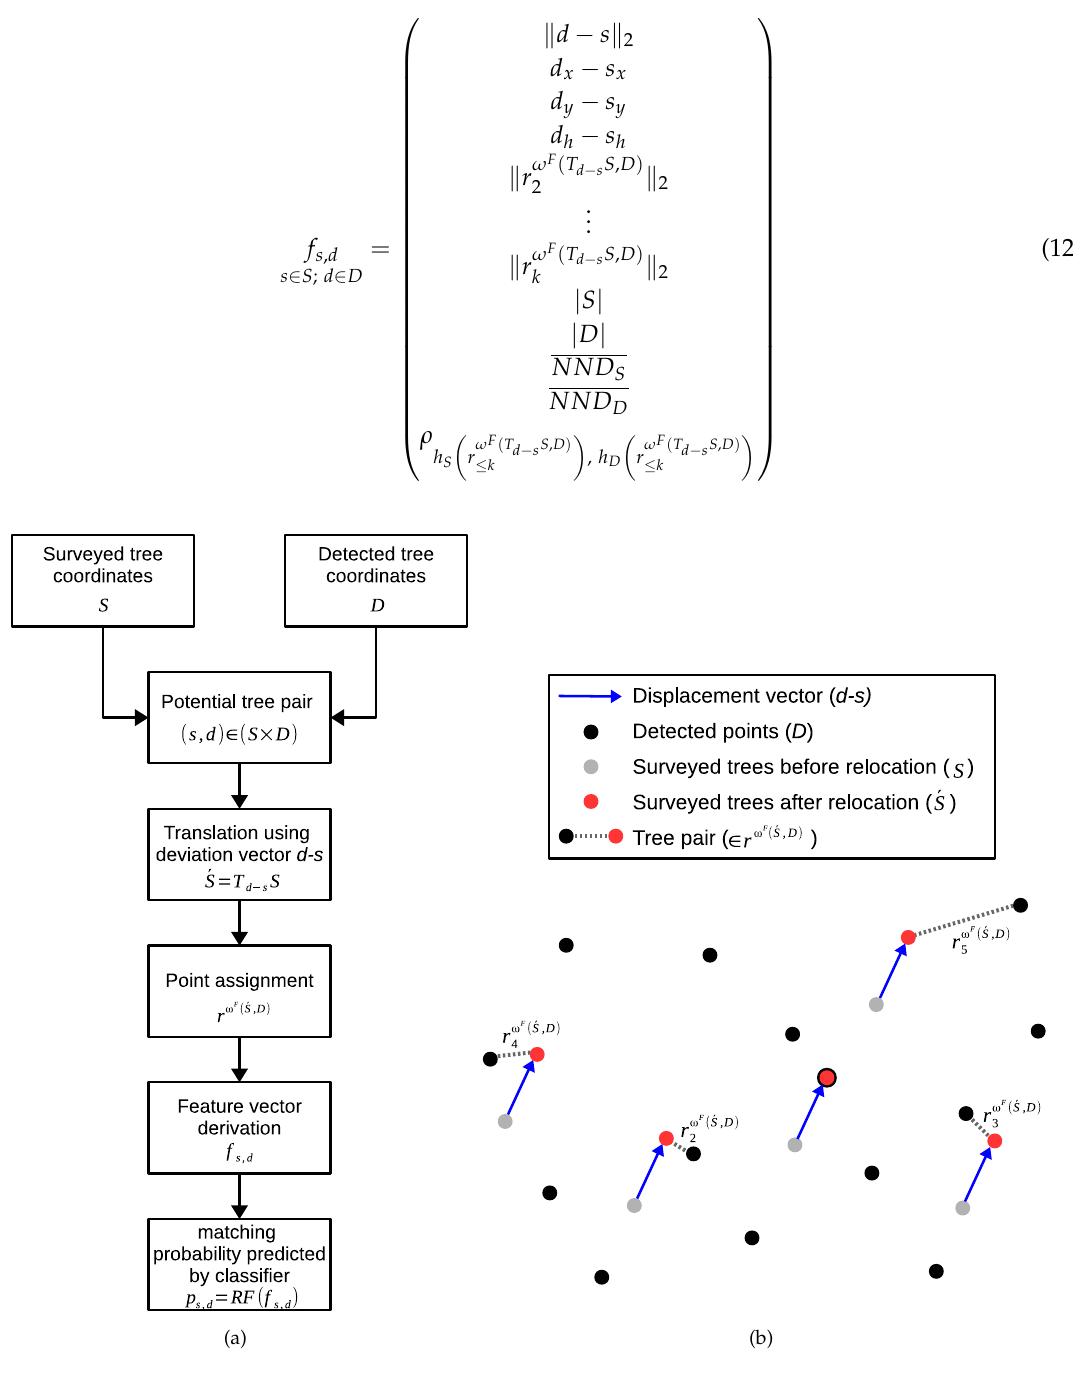
Figure 4. ( a ) Flowchart of the matching probability estimation for a given potential tree pair ( s , d ) and ( b ) corresponding schematic illustration of the feature vector calculation. RF : random forest